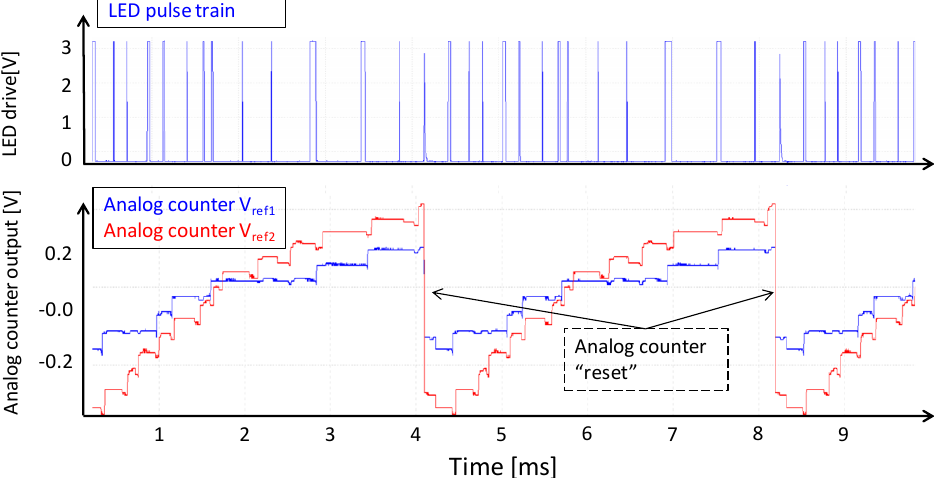
Figure 8. Signal of an analog counter during illumination of the QX2010 by a pulse train of LED pulses. X-axis: Time 0–1 ms; Y-axis: Red trace LED forward bias voltage; Blue trace analog counter voltage, measured real-time inside the circuit.